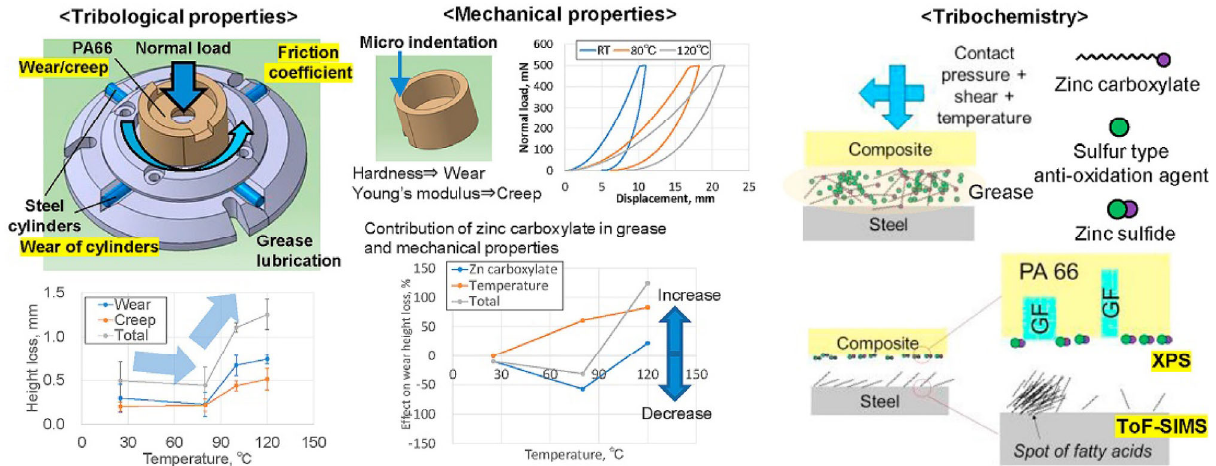
Fig. 6 Properties of glass-fiber reinforced PA66 using as friction pair [54]. Reproduced with permission from Ref. [54], © Elsevier Ltd.,